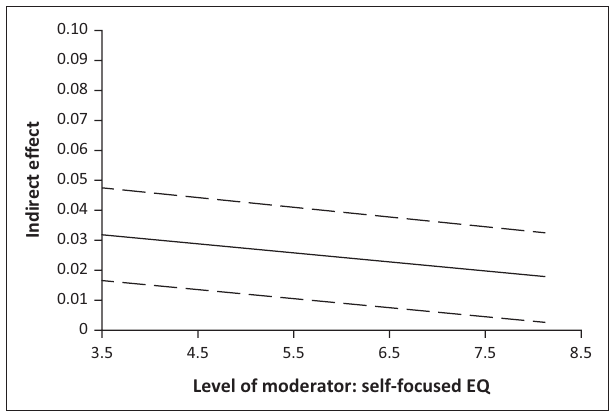
FIGURE 3: Conditional indirect effects of task conflict on in-role performance through task crafting at values of self-focused emotional intelligence.